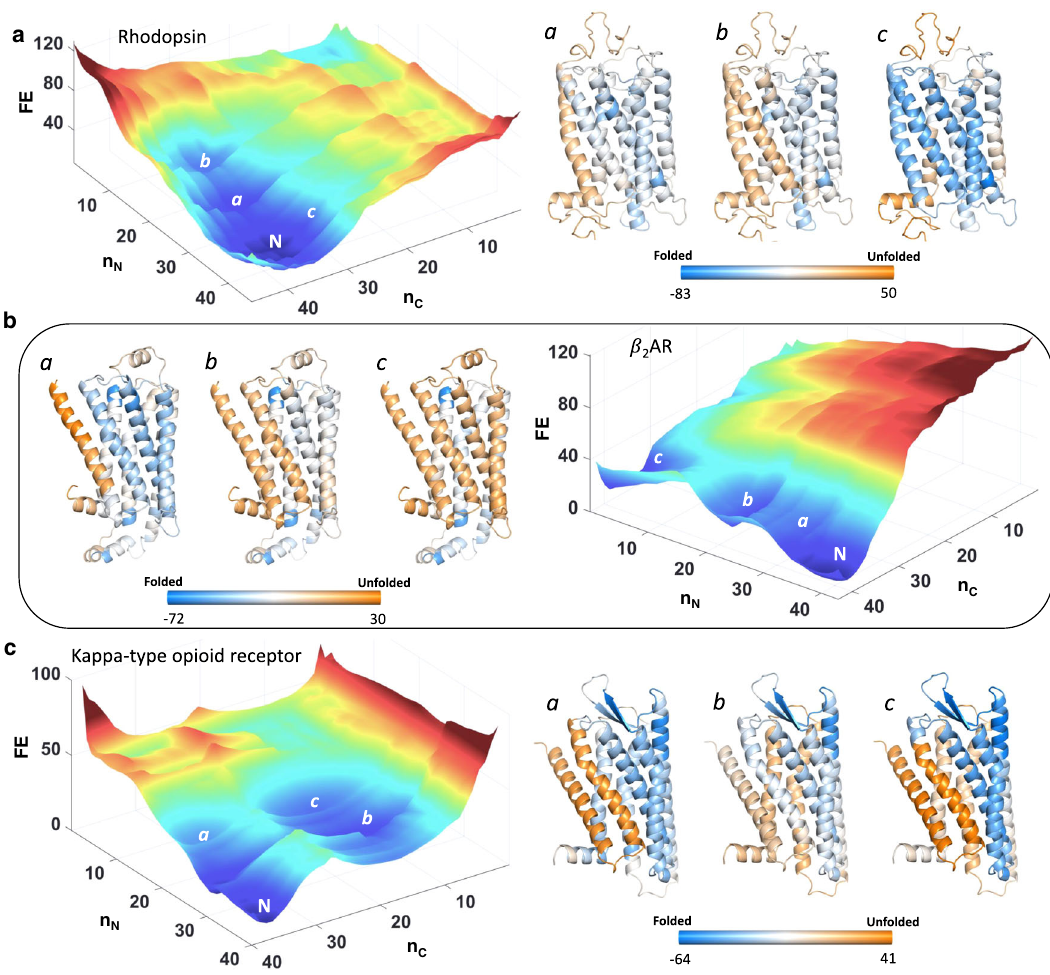
Fig. 3 | GPCR conformational landscapes and native ensemble heterogeneity. FreeenergylandscapesofRhodopsin( a ), β 2 AR( b